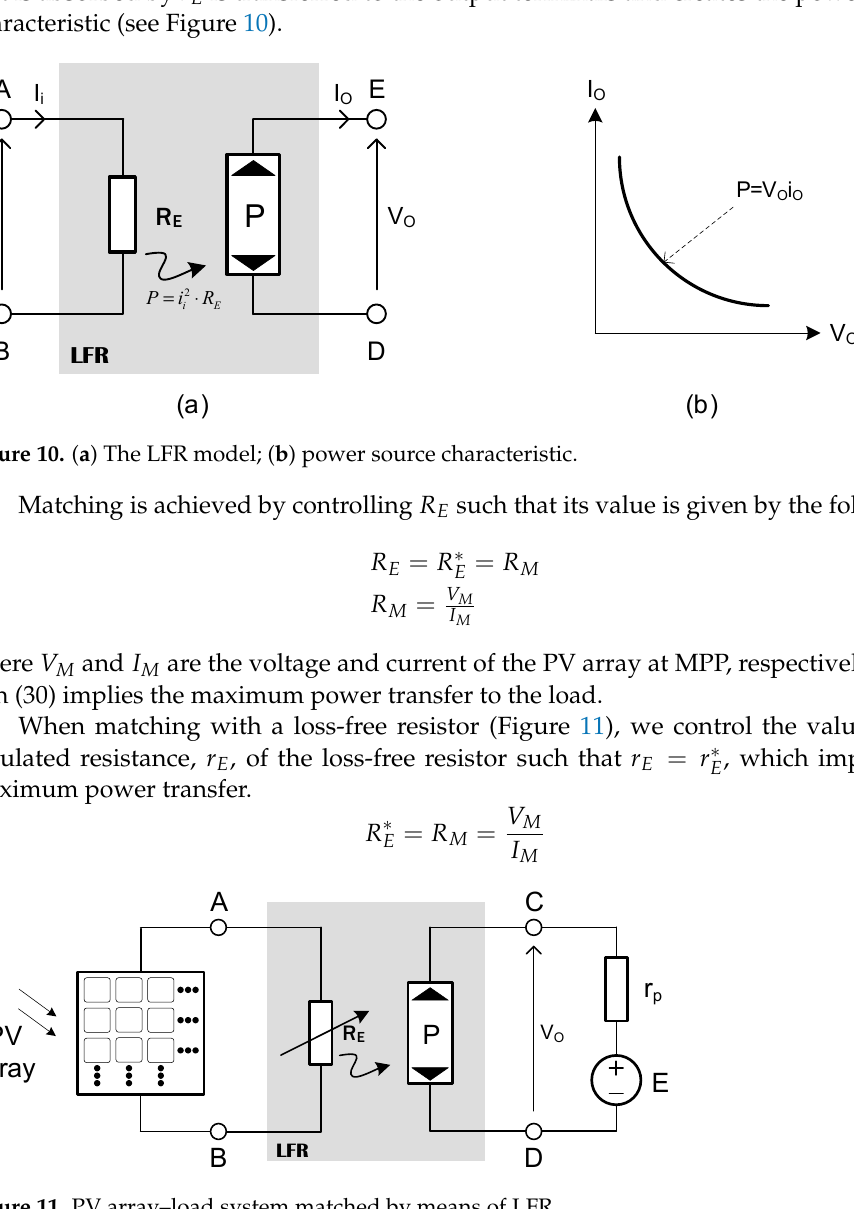
Figure 11. PV array–load system matched by means of LFR.